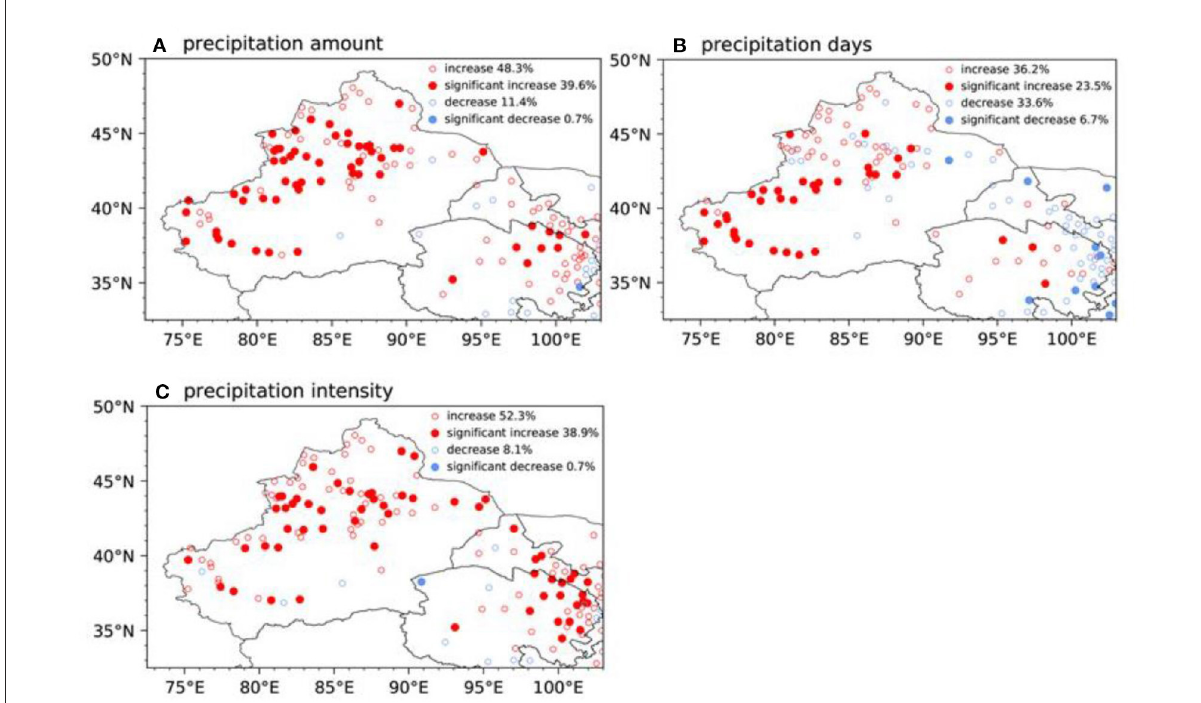
FIGURE4 Interdecadal variation distribution of (A) summer precipitation amount, (B) precipitation days, and (C) precipitation intensity over Northwest China (Xue et al., 2022).